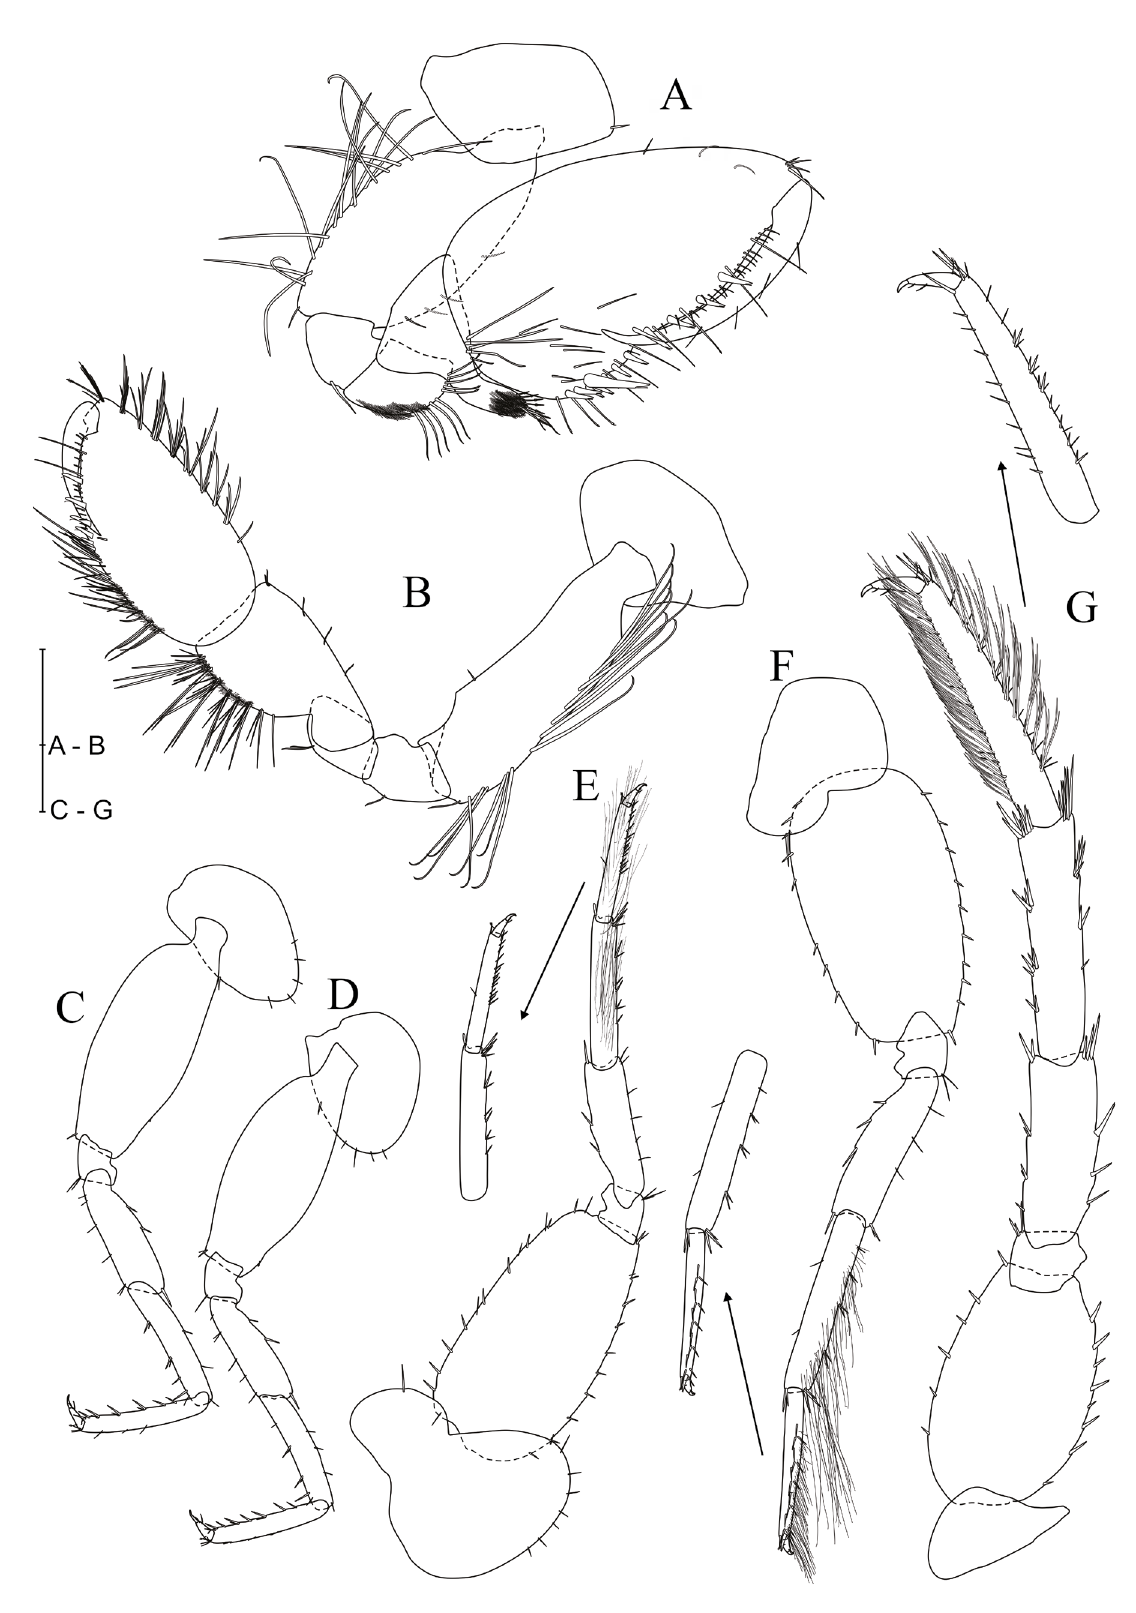
Figure 3. Spelaeogammarus ginae sp. nov., Gruna da Serra Verde cave, Serra do Ramalho, state of Bahia, Brazil. Paratype male, body length 11.31 mm; gnathopod 1 ( A ); gnathopod 2 ( B ); pereopod 3 ( C ); pereopod 4 ( D ); pereopod 5 ( E ); pereopod 6 ( F ); pereopod 7 ( G ). Scale bars: A, B = 400 μm; C–G = 1